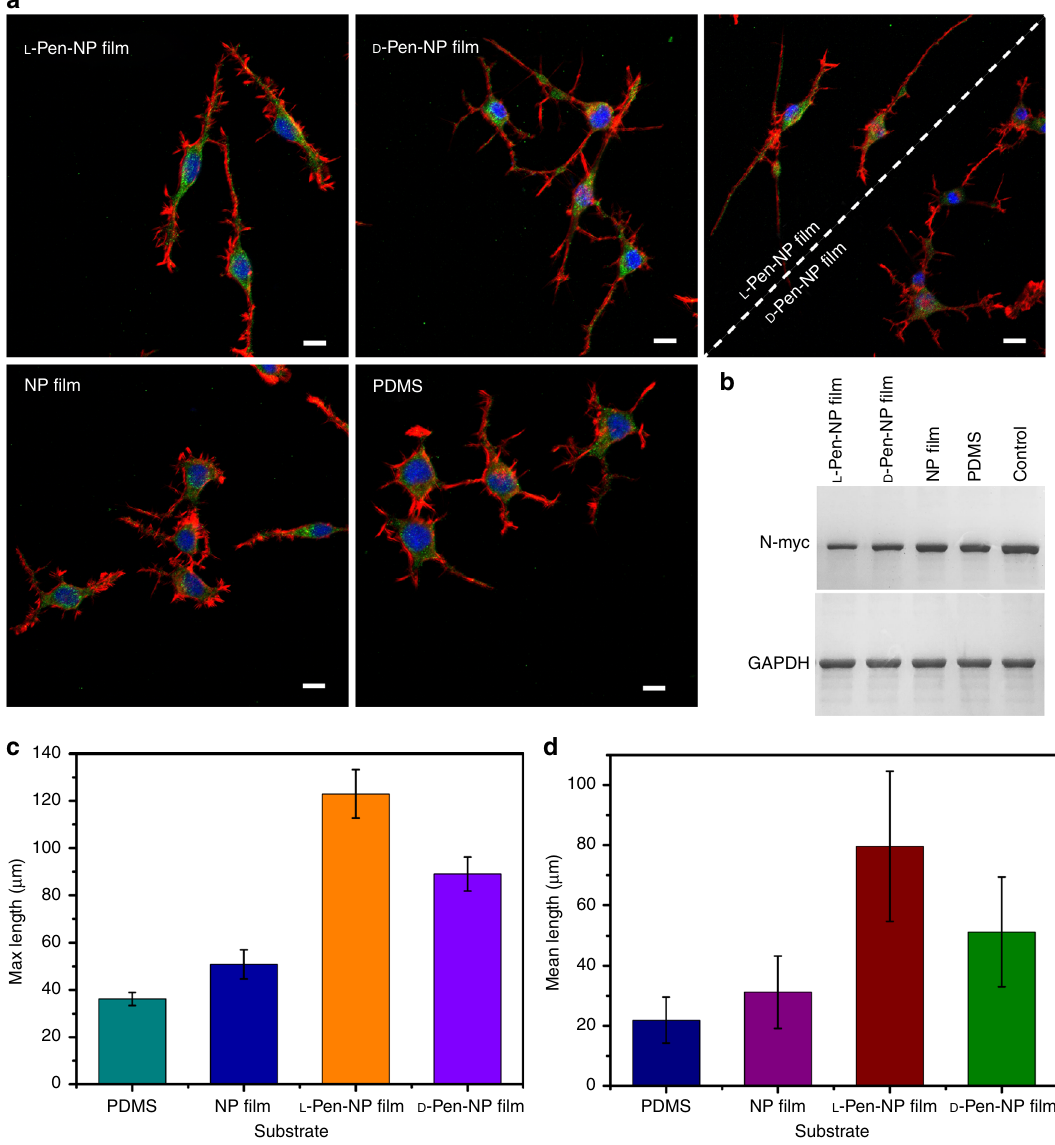
Fig. 4 Differentiation of NG108-15 cells on different substrates. a Confocal images of NG108-15 cells with addition of 1 μ M retinoic acid and cultured for 6 days. Scale bar, 20 μ m. b Expression of N-myc protein in differentiated NG108-15 cells, and GAPDH was used as a reference protein. c Max lengths of neurites. d Mean lengths of neurites. The error bars correspond to the standard error of the mean ( n =